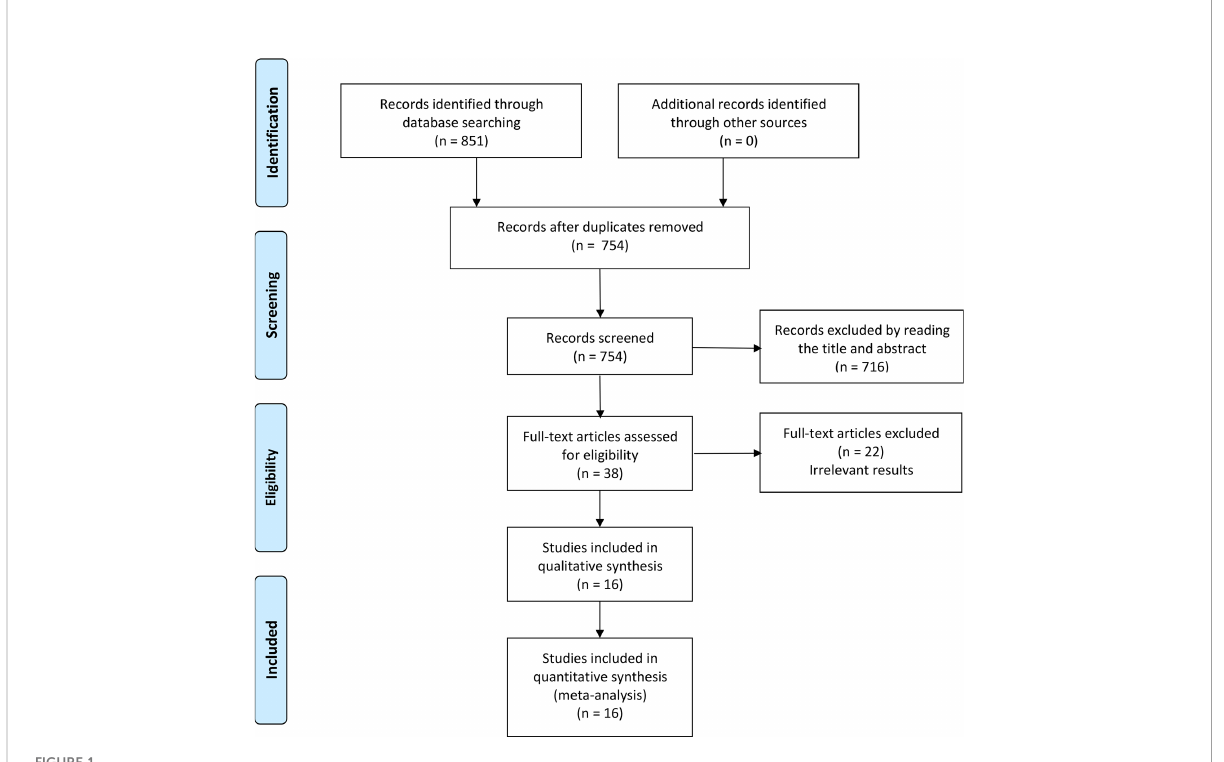
FIGURE 1 Flow diagram of the literature search and selection